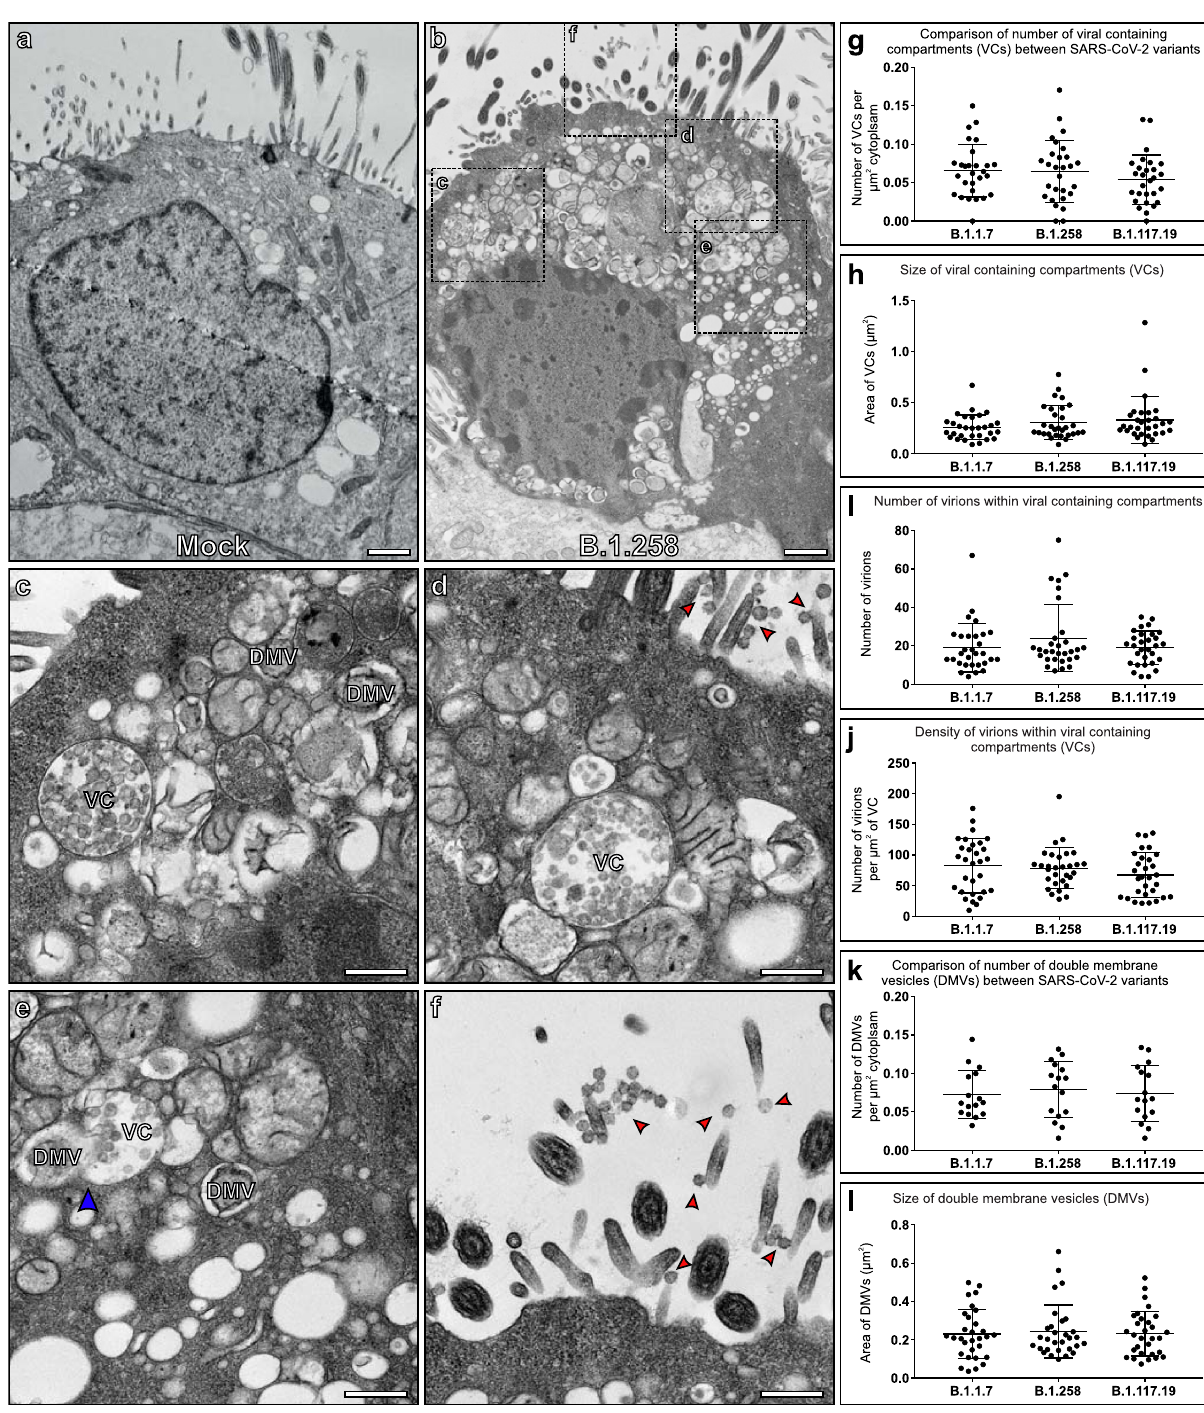
Fig. 1 Human nasal respiratory epithelium infected with SARS-CoV-2 show considerable remodelling to give way to viral replication. a A non-infected ciliated epithelial cell. b A cell infected with B.1.258 SARS-CoV-2 variant contains a large number of viral associated compartments shown at higher magni fi cation in ( c – f ) and virions at the cell surface (red arrowheads) ( d , f ). c – e Viral-containing compartments (VCs) and double-membrane vesicles (DMVs) can be seen. e Some DMVs are connected to VCs (blue arrowhead) and there are convoluted membranes surrounding these compartments. g – l Quantitation of features of VCs and DMVs from the three variants that include; g number of VCs within host cells, h size of VCs, i number of virions within VCs, j density of virions within VCs, k number of DMVs within host cells, and l size of DMVs. g N = 28 and k N = 16 cells were examined and h – j , l N = 30 VCs or DMVs were analysed. For measurements, no statistical signi fi cance was determined using paired, two-tailed Student ’ s t -tests. g – l Data were presented as mean values ± SEM. Scale bars ( a , b ) 1 μ m and ( c – f ) 400 nm.